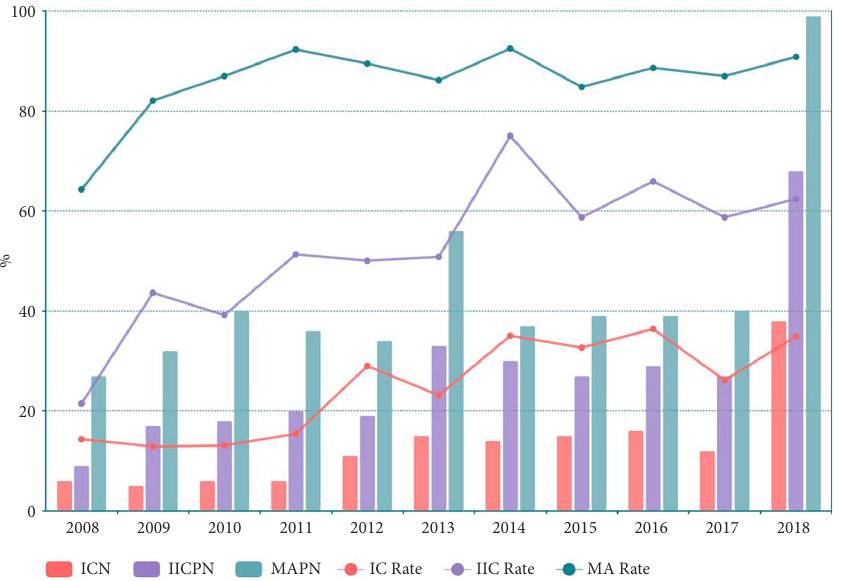
Figure 1. The number of cooperative papers and the rates of